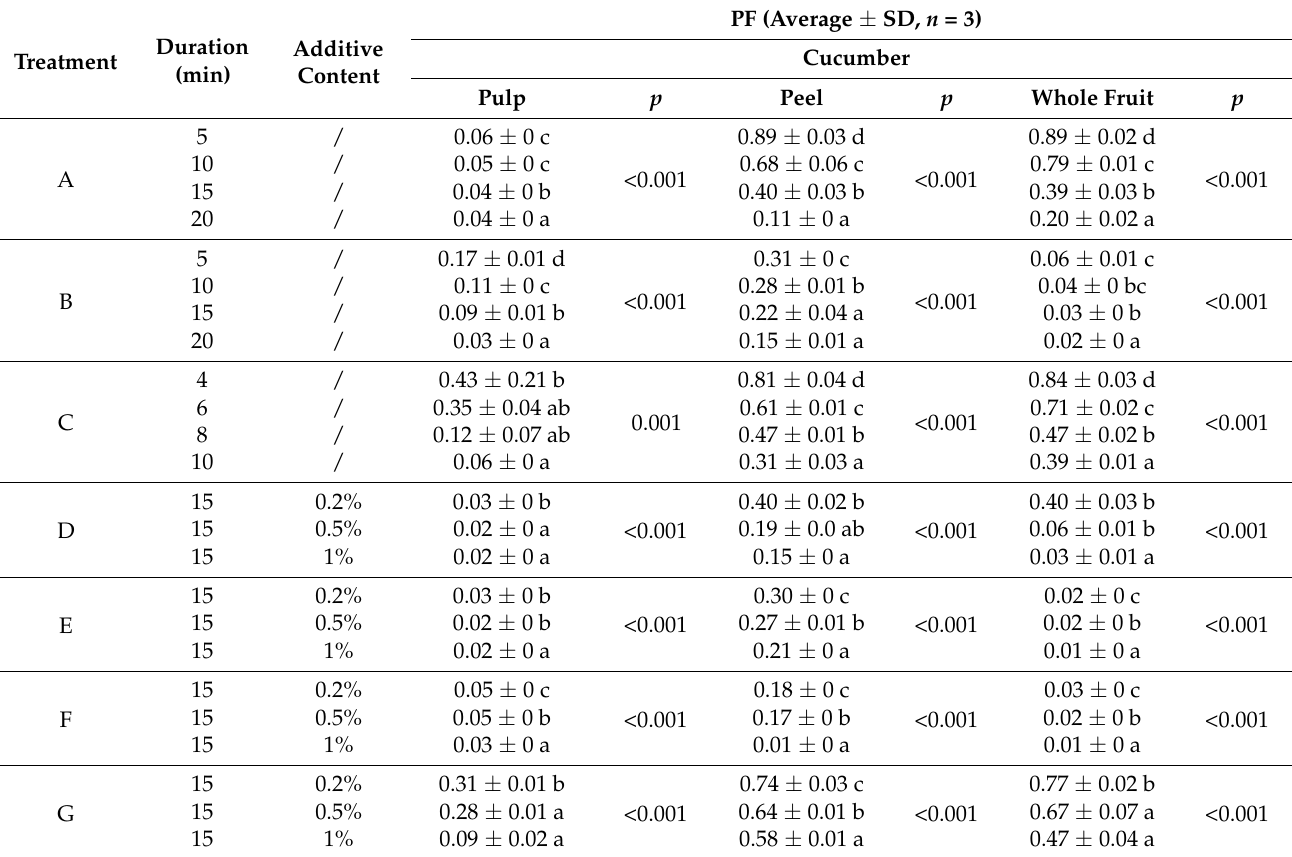
Table 4. PF values of racemic penthiopyrad in cucumber samples after different soaking methods.